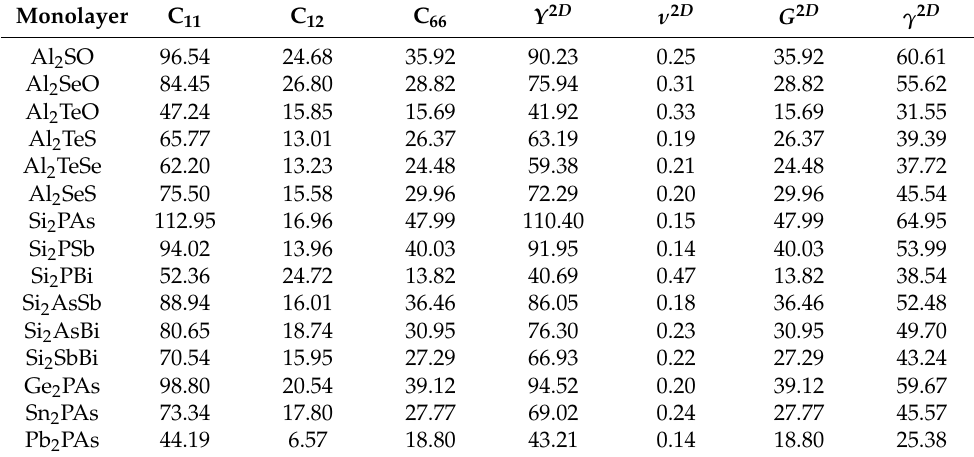
Table 2. The 2D elastic constants C ij (N/m), Young modulus Y 2 D (N/m), Poisson ratio ν 2 D ,